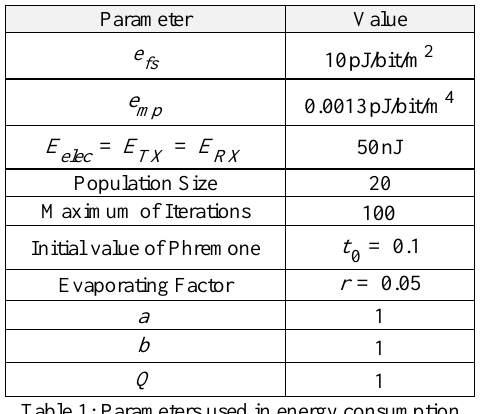
Table 1 represents the simulation parameters and Required optimal parameters in the Genetic algorithm respectively ) Ebrahimi, Pahlavani et al. 2017) .